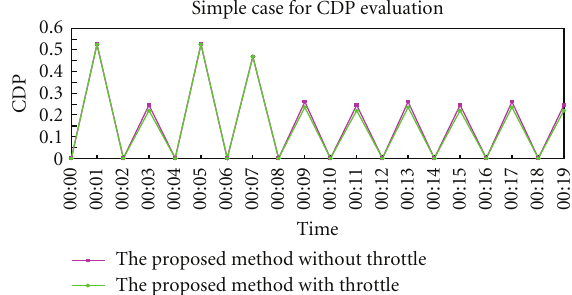
Figure 9: Comparison of CDPs without throttle and with throttle for simple case.